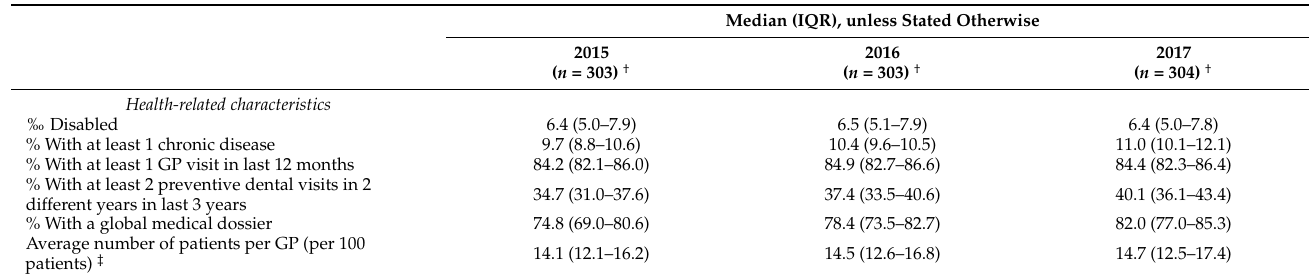
The percentages of men and age groups were captured for the colorectal cancer screening population in each municipality. Other characteristics were captured for the whole population in each municipality and were used as proxies for the colorectal cancer screening population. † Number of municipalities included in the analysis, for which data for all the study variables were available (cell ≥ 5 events). ‡ For statistical purposes, average income was divided by 1000 and average number of patients per GP was divided by 100 before inclusion into analyses. IQR, interquartile range; CRC, colorectal cancer.